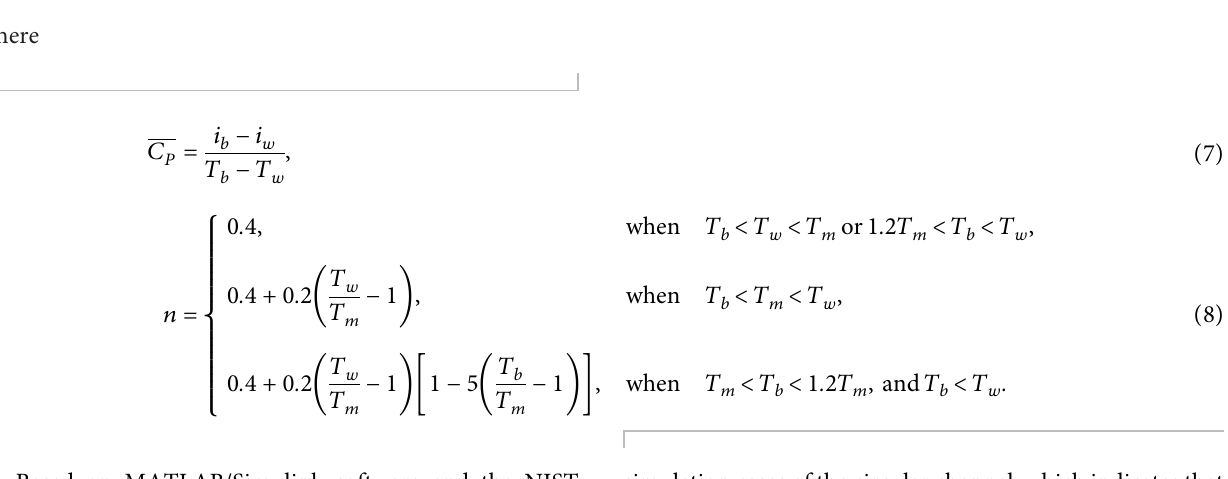
Figure 9: Comparison of simulated data with the calculated heat convection coefficients using Jackson correlation as a function of T (a) heating case; (b) cooling